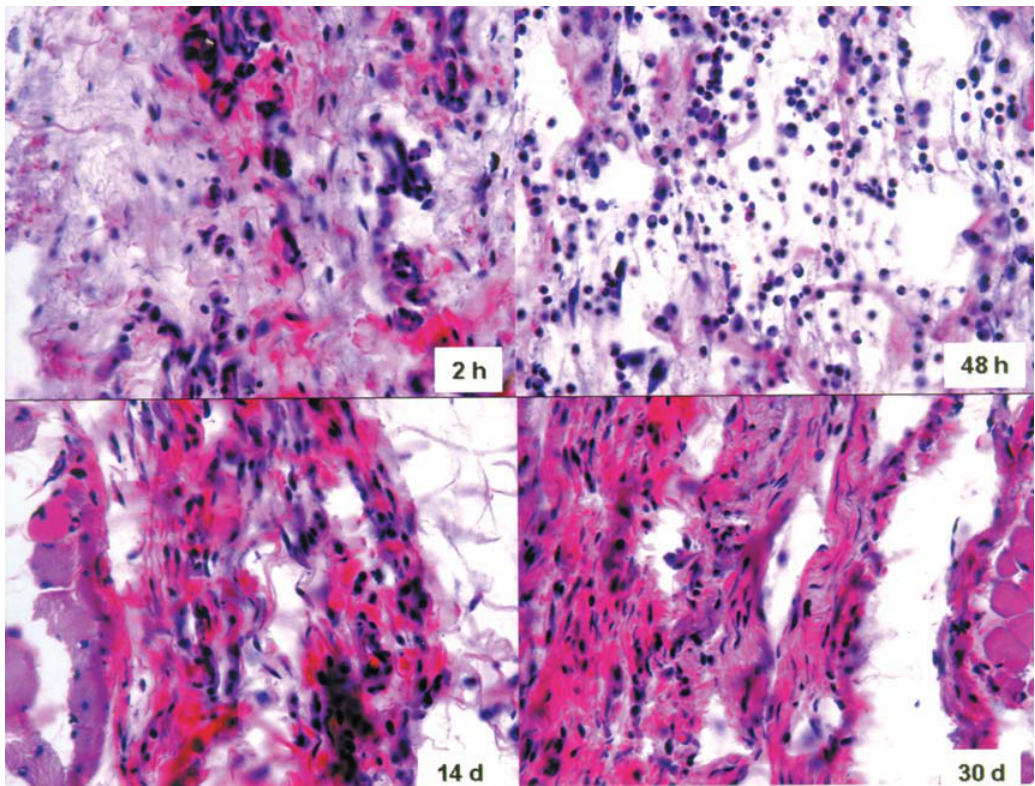
FIGURE 1 - Reaction of rat subcutaneous connective tissue to the empty injector (no irrigant) – Control Group (H.E.; x25)